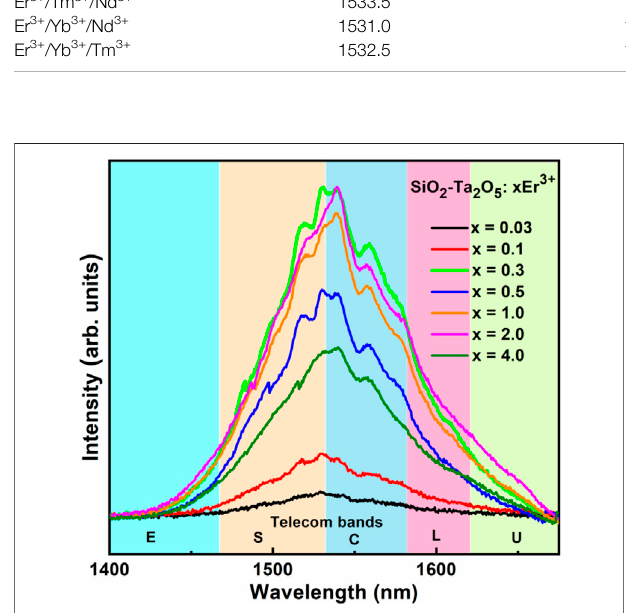
FIGURE 10 | Photoluminescence decay curves of the 4 I 13/2 → 4 I 15/2 transition of Er 3+ ions in the 0.1, 0.3, 0.5, 1.0, 2.0, and 4.0 mol% Er 3+